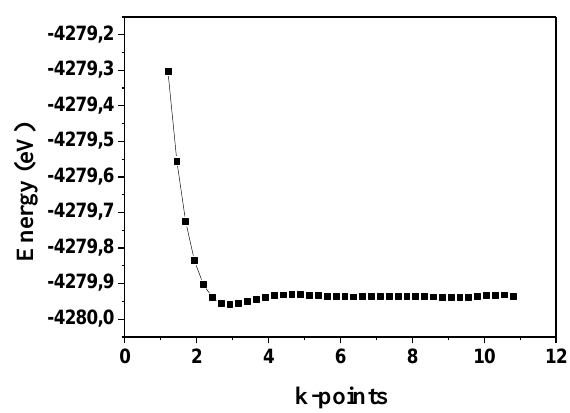
Fig. 3. Energy versus number of k points of our computed compounds.